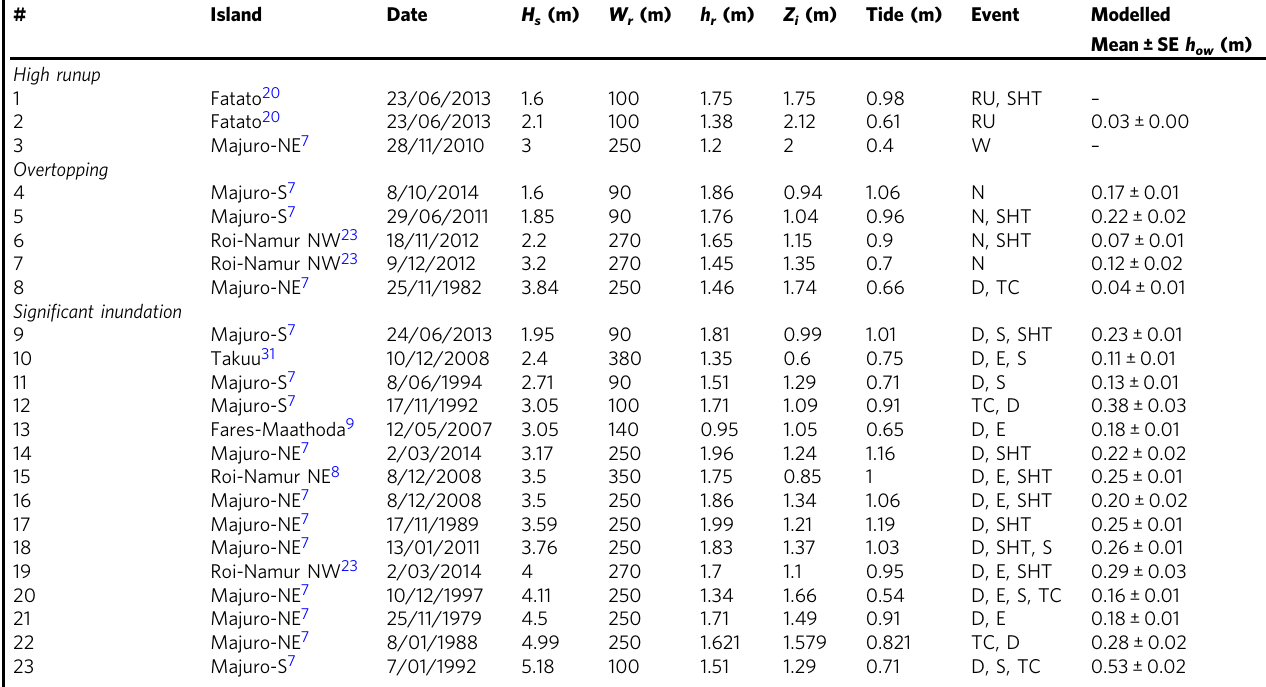
Table 1 Documented wave runup, overtopping and inundation events used to compare model outputs